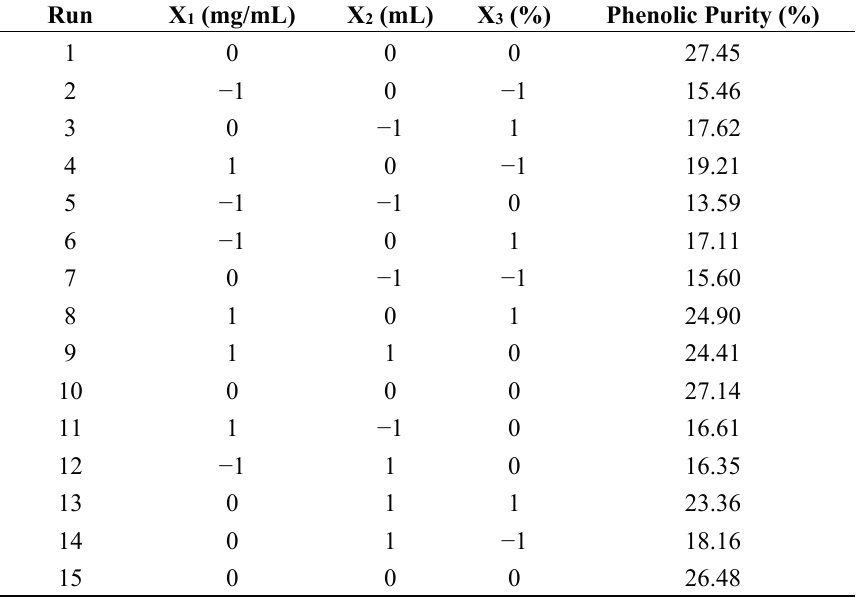
Table 1. Box-Behnken experimental design with the independent variables ( n = 3). Run X 1